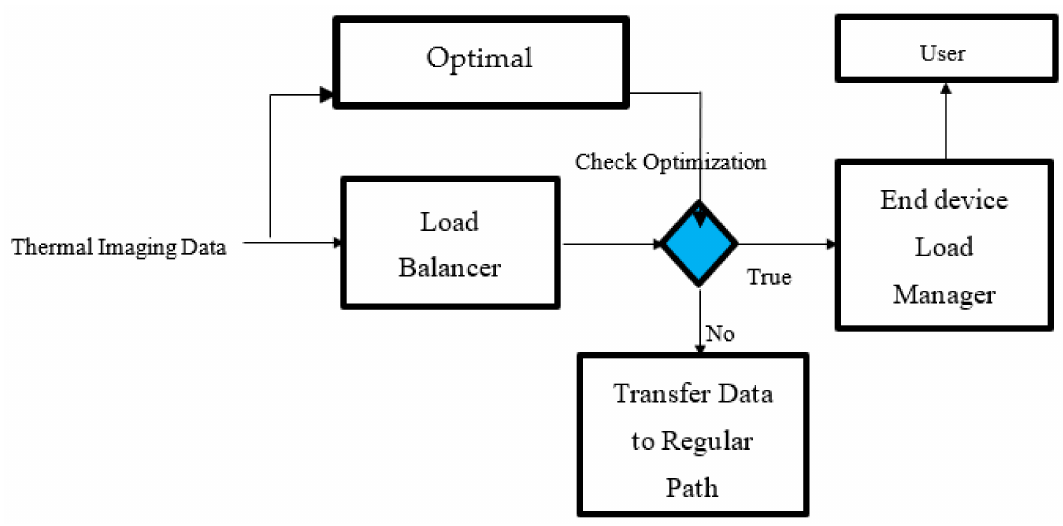
Figure 3. Load balancer operation.